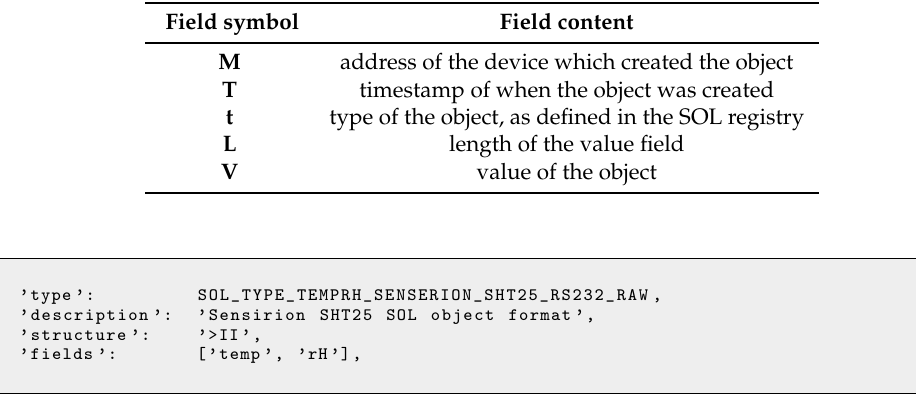
Table 1. Fields contained in a SOL object.